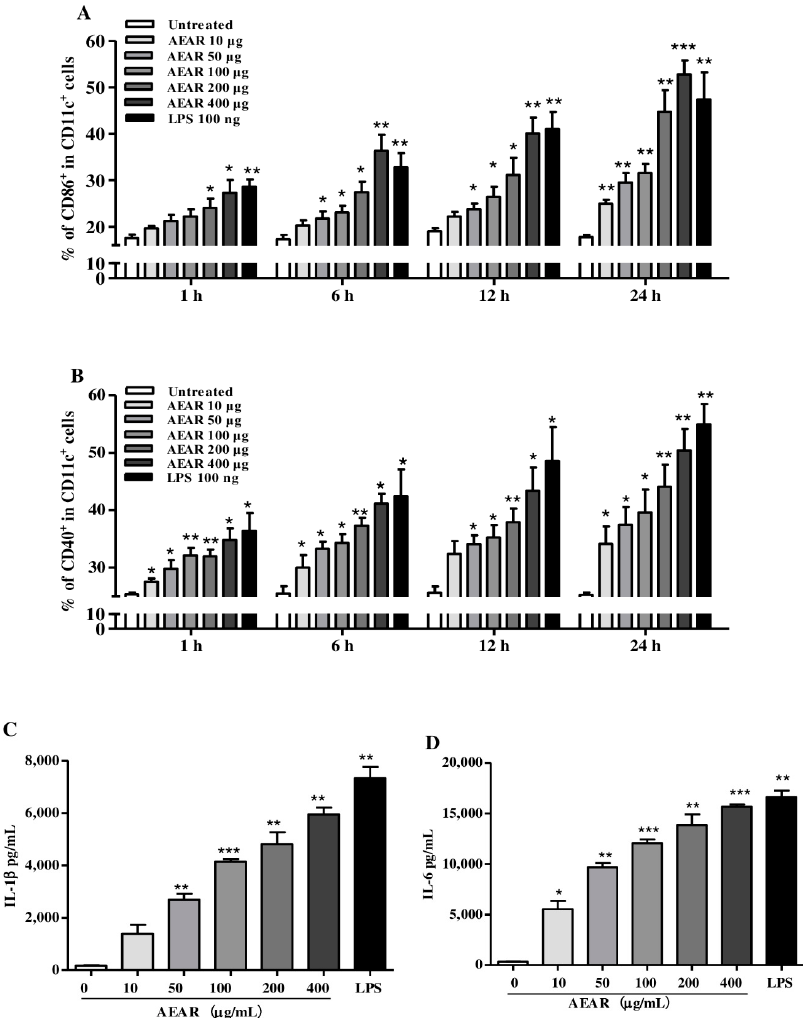
Figure 4. AEAR induced DCs’ activation. ( A–B ) Immature DCs were treated with AEAR or LPS for different periods. DCs were harvested and then stained with anti ‐ CD11c, anti ‐ CD40, and anti ‐ CD86 antibodies. The expression levels of CD40 and CD86 were analyzed with a flow cytometer. ( C–D ) The expression levels of IL ‐ 1 β and IL ‐ 6 in culture supernatants were analyzed by ELISA kit. Data were expressed as means ± SD (n = 3). * p < 0.05, ** p < 0.01, and *** p < 0.001 indicate significant differences compared with the untreated control, determined by one ‐ way analysis of variance (ANOVA) and Tukey’s multiple ‐ comparison